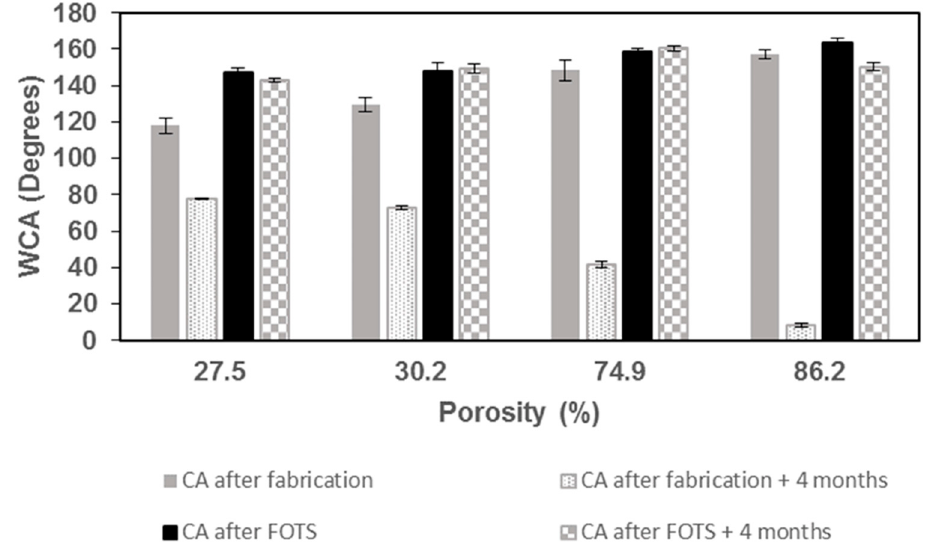
Figure 5. Water contact angle (WCA) as a function of porosity: values of WCA for MacroPSi surfaces after fabrication, after 4 months of fabrication, after FOTS modification and after 4 months of FOTS functionalization.